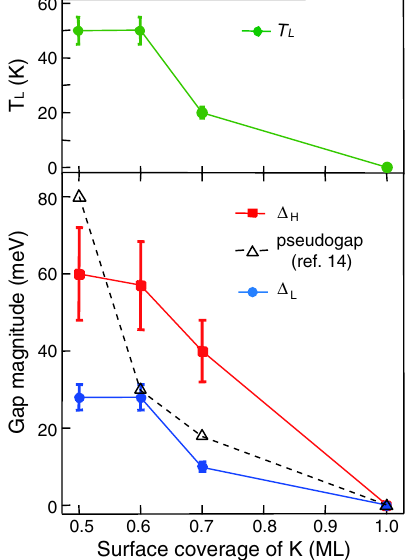
FIG. 5. Δ H , Δ L , and T L as a function of the surface coverage of potassium. The gap magnitude of the pseudogap observed at the antinode by ARPES is shown by empty triangles for comparison [14].